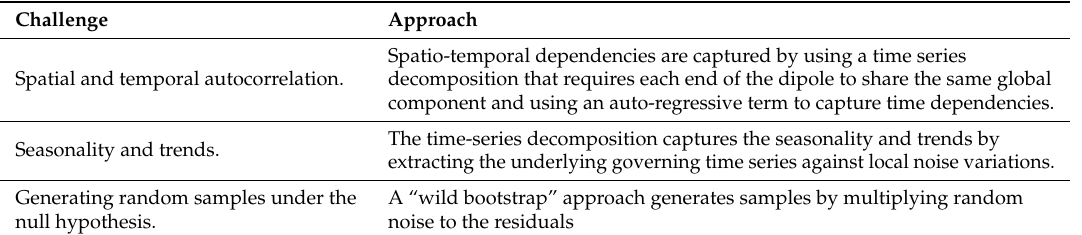
Table 1. Approaches for addressing challenges of statistical significance testing of teleconnection patterns. Challenge Approach Spatio-temporal dependencies are captured by using a time series Spatial and temporal autocorrelation. decomposition that requires each end of the dipole to share the same global component and using an auto-regressive term to capture time dependencies. Seasonality and